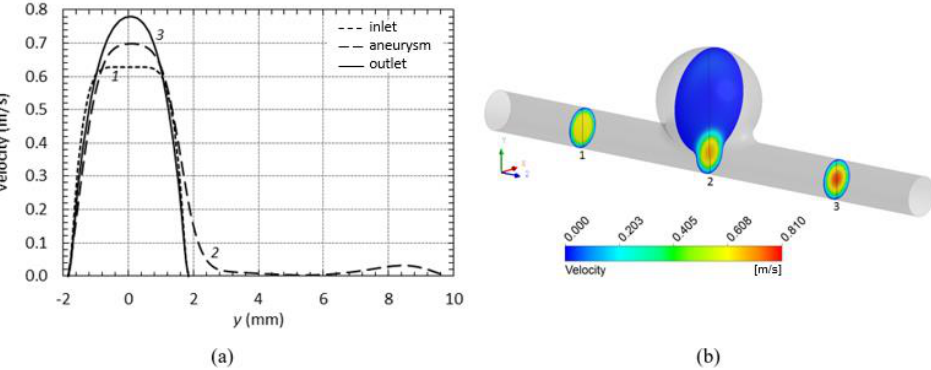
Figure 8. ( a ) Velocity profiles in three different regions of the channel for Newtonian model and u = 444 mm/s. (b) Three cutting planes corresponding to the curves of (a), respectively.